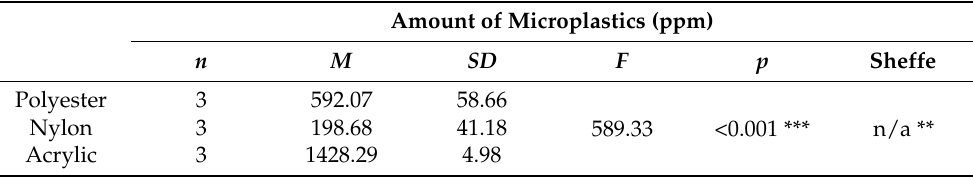
Table 2. Analysis of variance (ANOVA) for factors affecting the release of fibers as a consequence of various